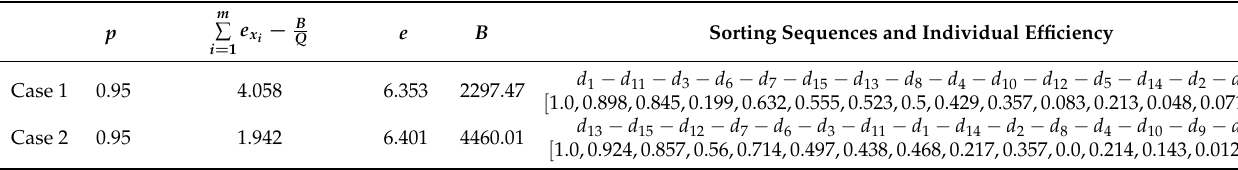
Table A7. Solutions of sorted negotiation Model (21). Sorting Sequences and Individual Efficiency